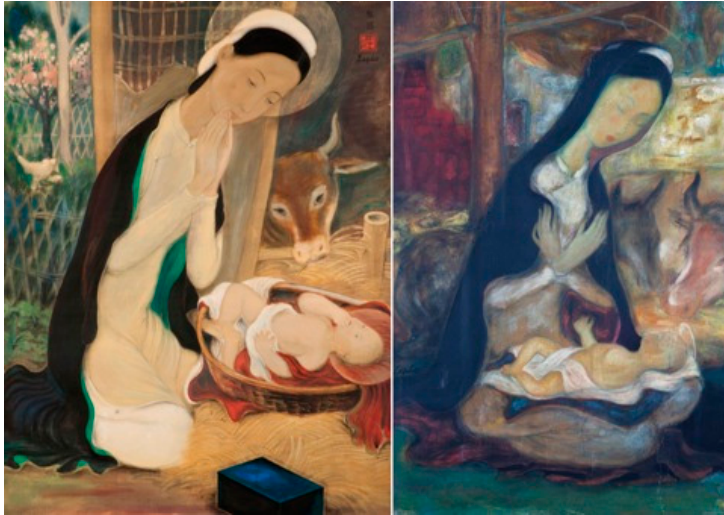
Figure A20. Giang sinh —Le Pho. On the left auctioned at Christie’s, May 2011 and then November 2015. On the right auctioned at Sotheby’s, April 2016. The image was sourced from The Thao & Van Hoa Newspaper (Bay 2016a).